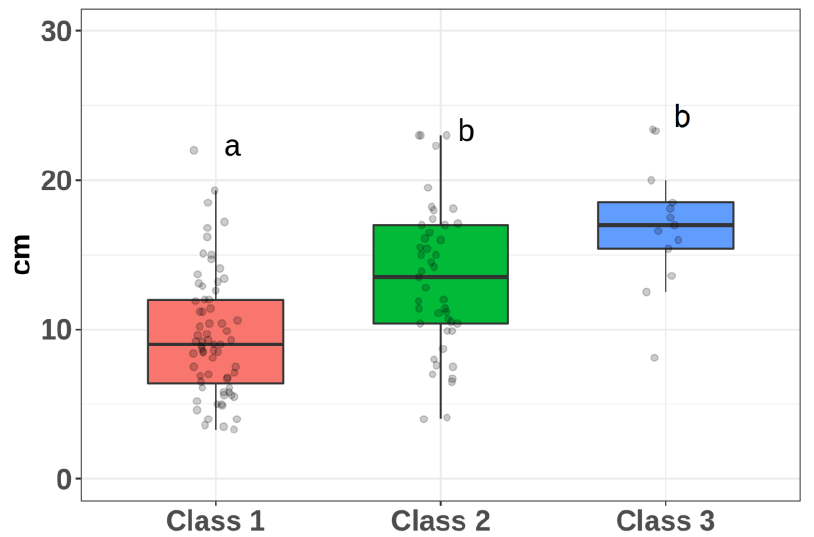
Figure 5. Dependence of the DBH on the spatial structure factor. The lower and upper hinges cor- respond to the first and third quartiles (the 25th and 75th percentiles), and the centerline corre- sponds to the median. The upper whisker extends from the upper hinge to the largest value no further than 1.5*IQR from the hinge (where IQR is the interquartile range or distance between the first and third quartiles). Likewise, the lower whisker extends from the lower hinge to the smallest value no further than 1.5*IQR from the hinge. The different lower case letters (a, b, c) above the means of the treatments (Class 1, 2, 3) are significantly different at p = 0.05. Points on the plot were offset to avoid overplotting of identical values